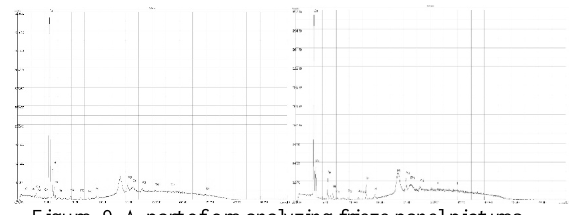
Figure. 9. A part of ore analyzing frieze panel